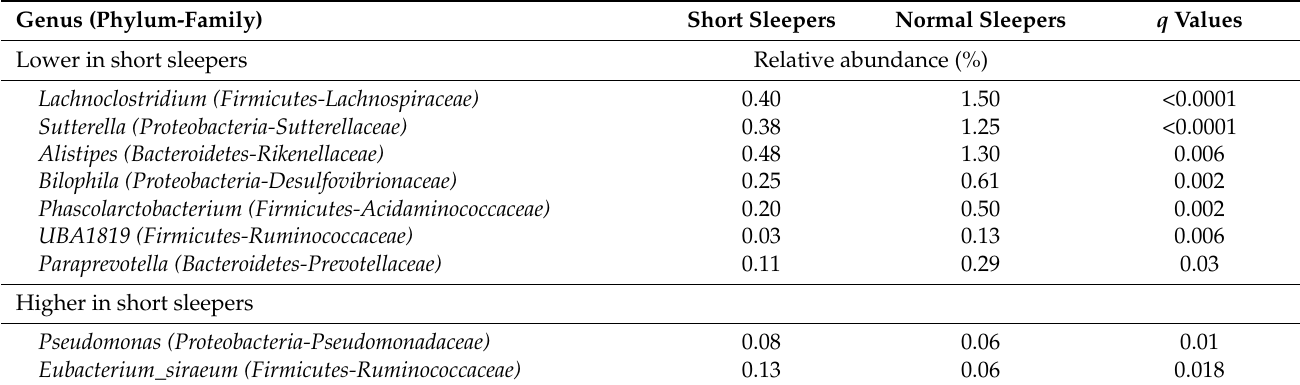
Table 2. Relative abundance (%) of the bacterial genera in short sleepers and normal sleepers.